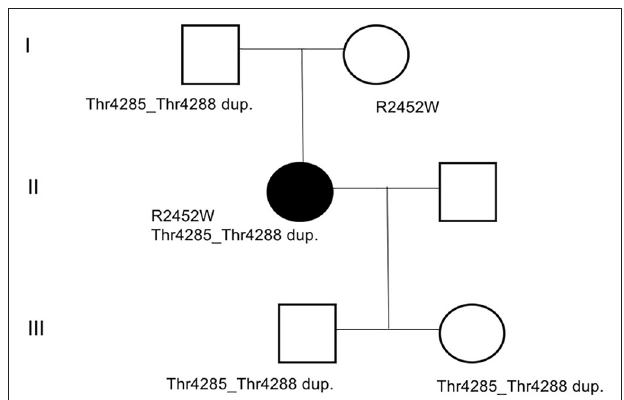
FIGURE 1 | Family pedigrees. The black filled symbol represents the affected proband. Sequence analysis of the proband RYR1 gene identified a missense mutation (c.7354C > T) in exon 46, resulting in the substitution of an Arg in position 2452 with a Trp (p.R2452W), and a duplication c.12853_12864dupACGGCGGCCACG involving 4 amino acid residues (Thr, Ala, Ala, Thr, p.Thr4285_Thr4288dup) in exon 91. The genotype of family members tested is reported below each